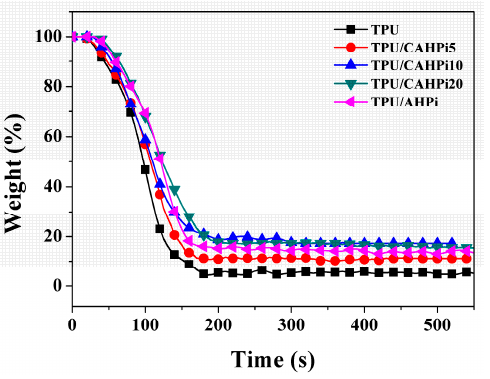
Figure 4. Weight loss of TPU and its nanocomposites during combustion.